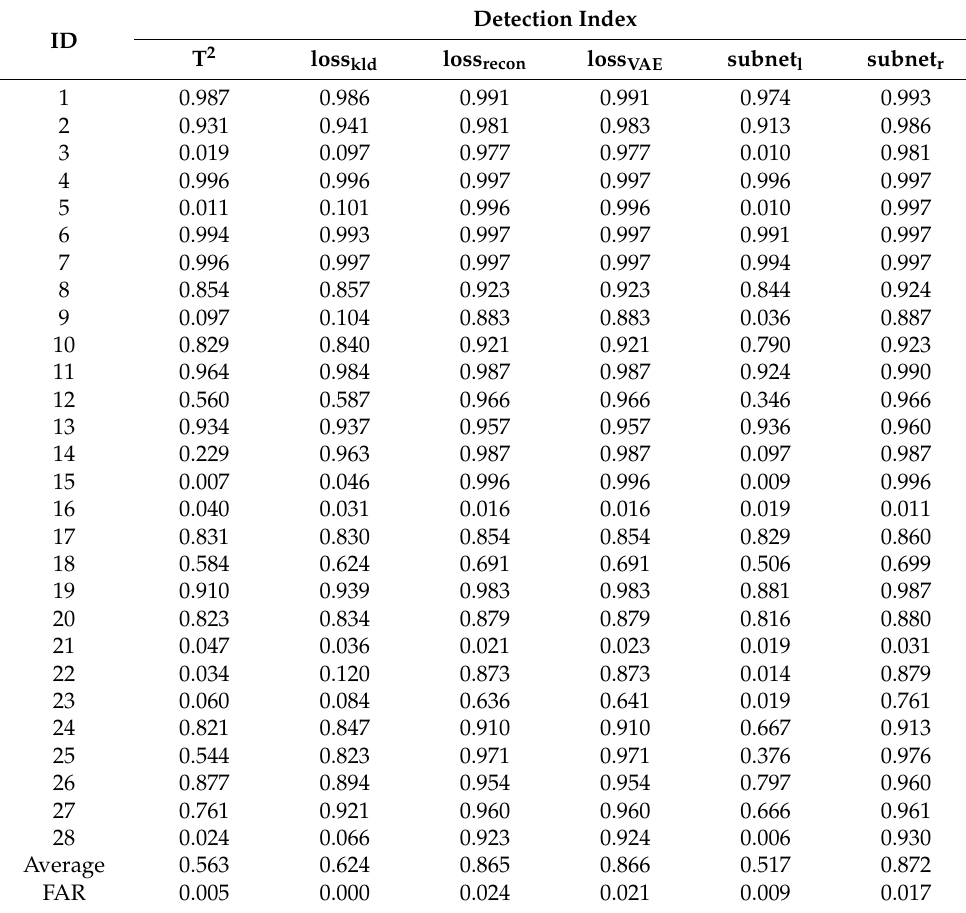
Table 5. Fault detection by LSTM-VAE.